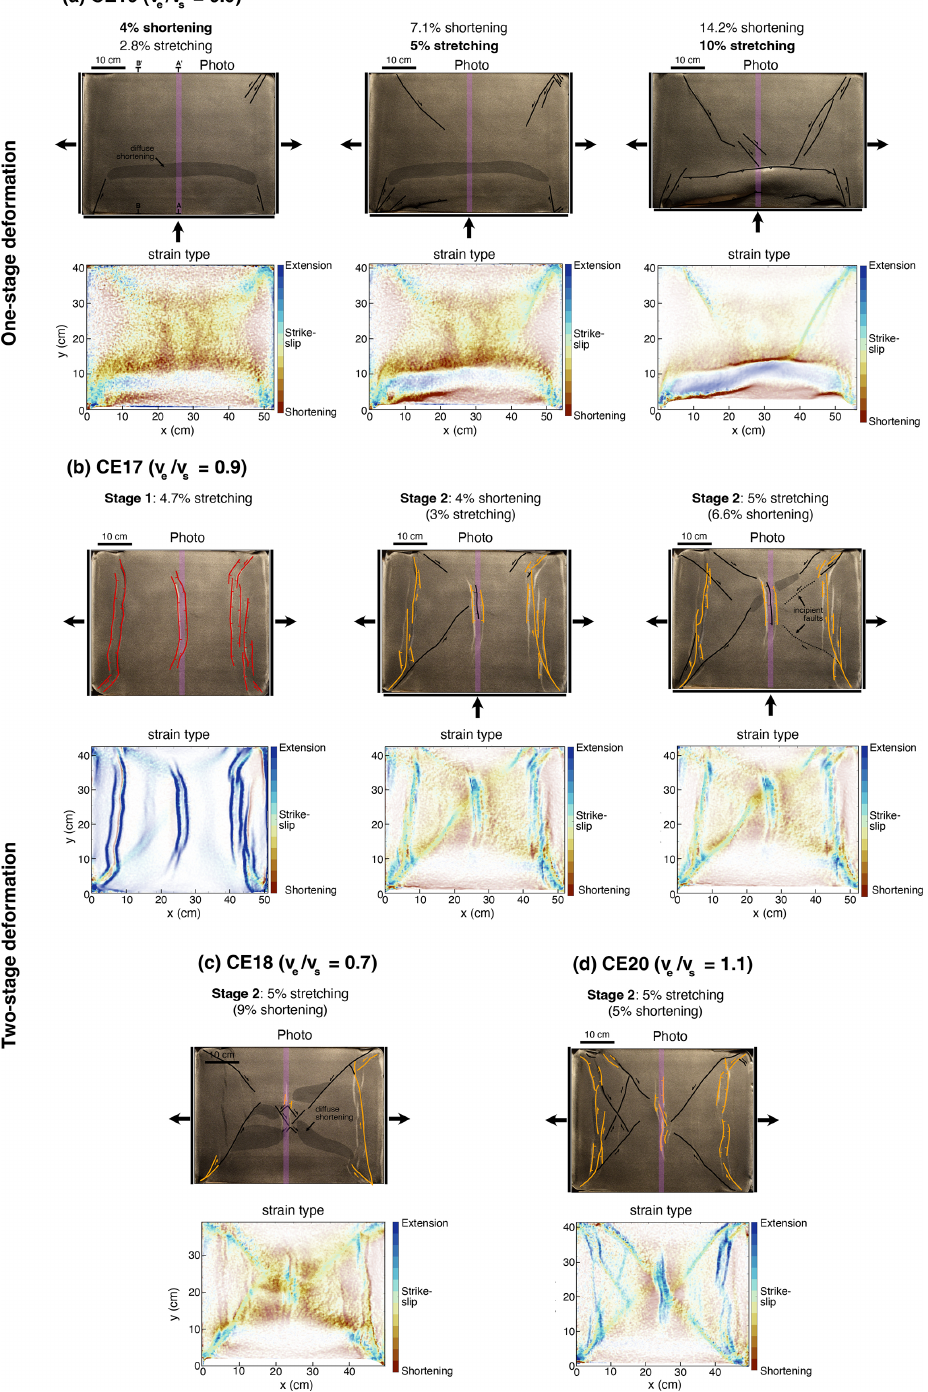
Figure 6. Interpreted pictures and strain type for models with a brittle–ductile crust and one-stage deformation ( a model CE16) and two- stage deformation ( b model CE17, c model CE18, and d model CE20). Strain type maps show shortening (red), strike-slip (green), and stretching (blue), with intermediate, oblique deformation at intermediate colors. For the two-stage models, faults active only at the first stage of deformation are in red, faults forming and active only at the second stage are in black, and faults that formed at the first stage and are reactivated at the second stage are in orange. The initial location of the seed is indicated in purple. The corresponding amount of along- x stretching and/or along- y shortening is indicated at the top. Corresponding maps for principal stretches λ max , λ min are found in Fig. S3.